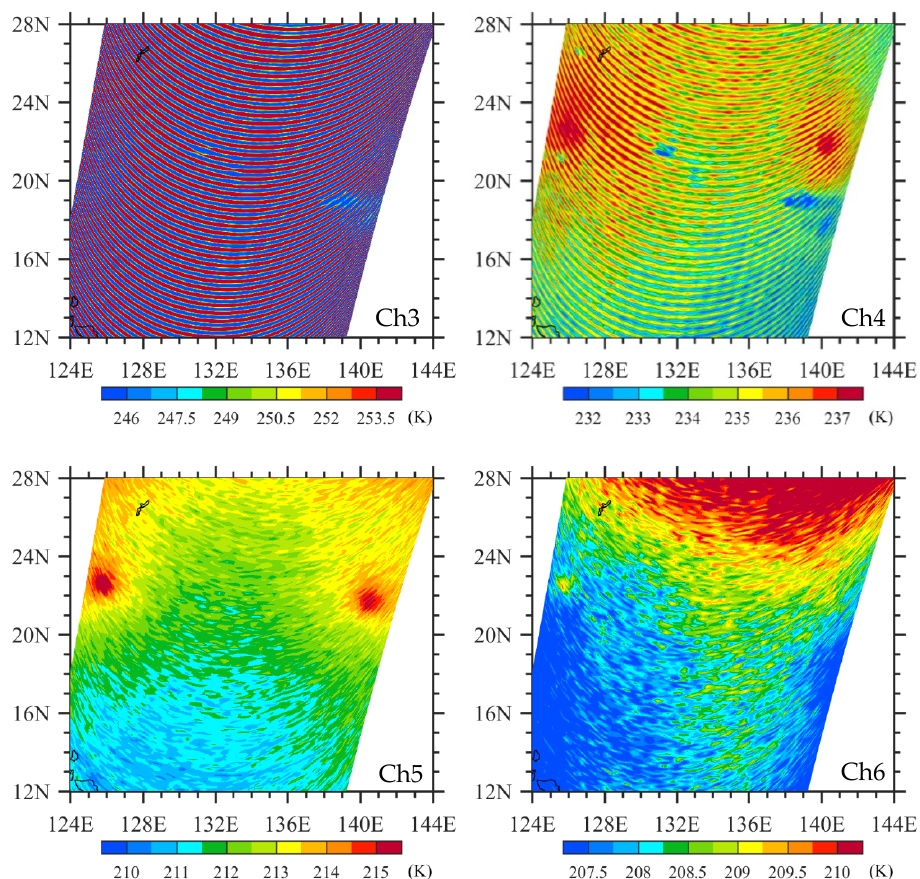
Figure 4. TB observations at channels 1–6 over a portion of the swath in Figure 3a.